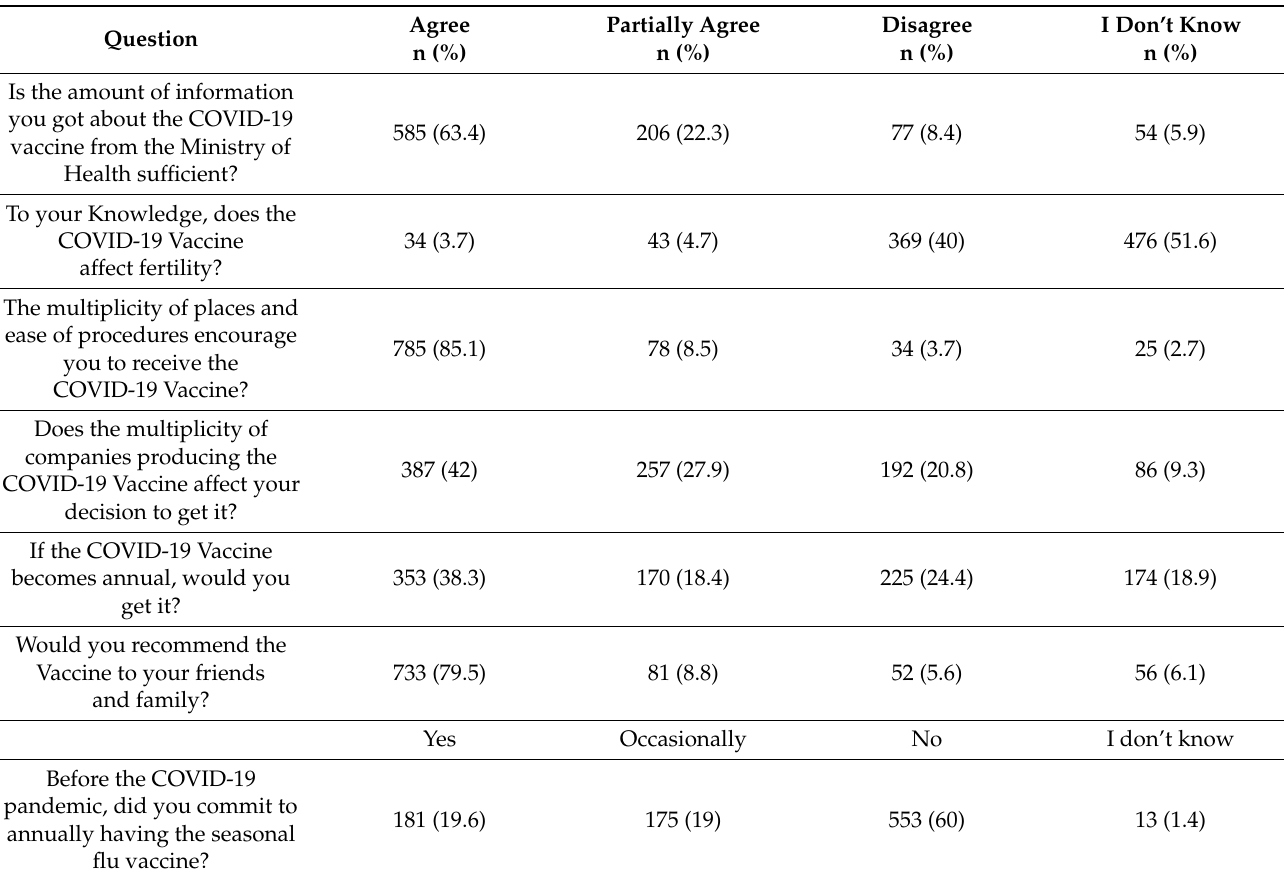
Table 2. Participants’ responses toward knowledge about the COVID-19 vaccine and its affecting factors (n =